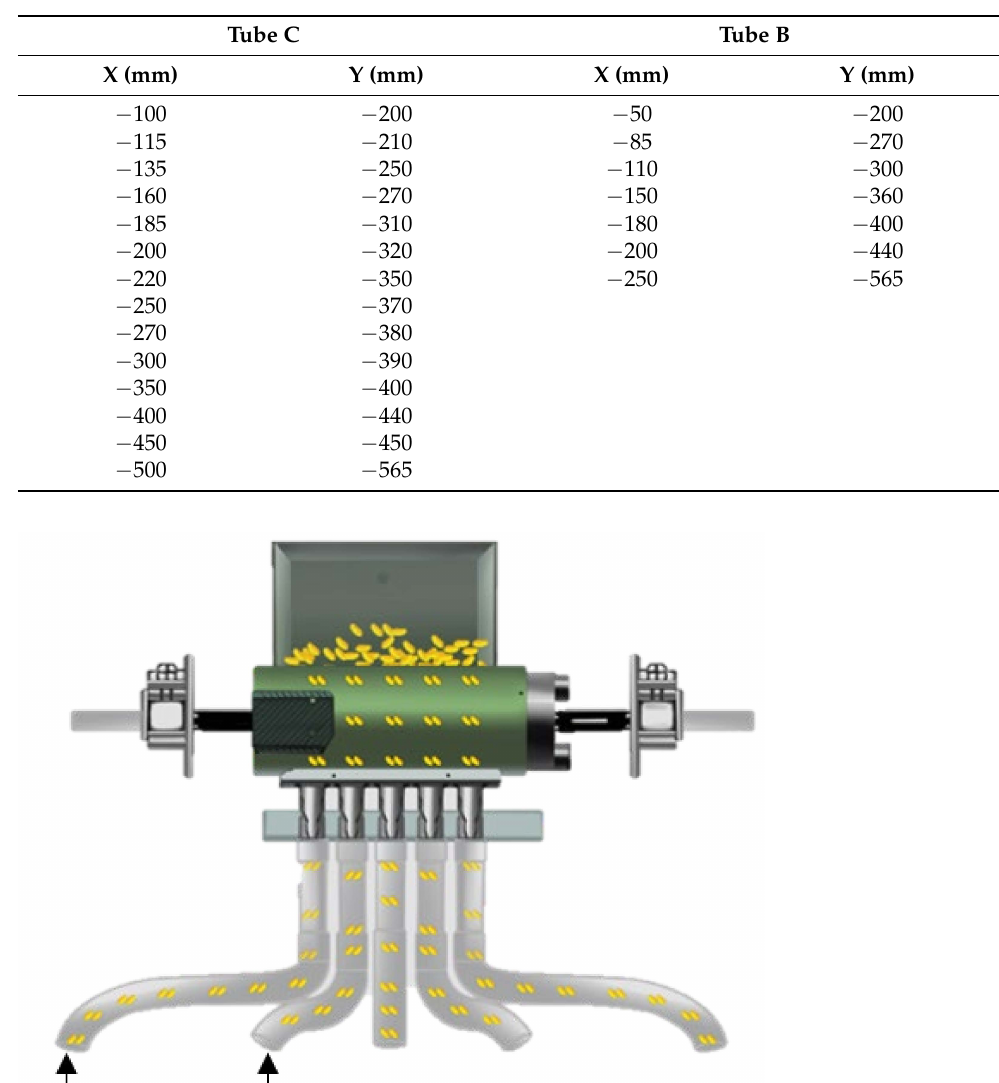
Table 8. The coordinate point data of different seed-feeding tubes.